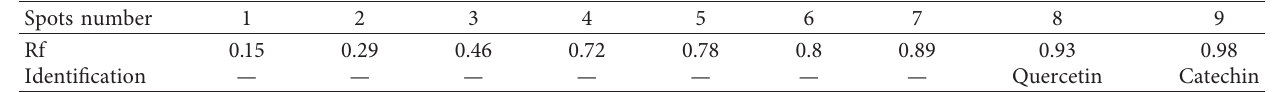
Figure 6: Chromatography plates after development: (a) under UV 254 light, (b) under white light with bands circled, and (c) schematic representation. a � deposit line, b � front line, and 1, 2, 3, 4, 5, 6, 7, 8, and 9 are bands observed under UV light. Table 8: Rf values of the compounds of the optimized soybean meal extract.